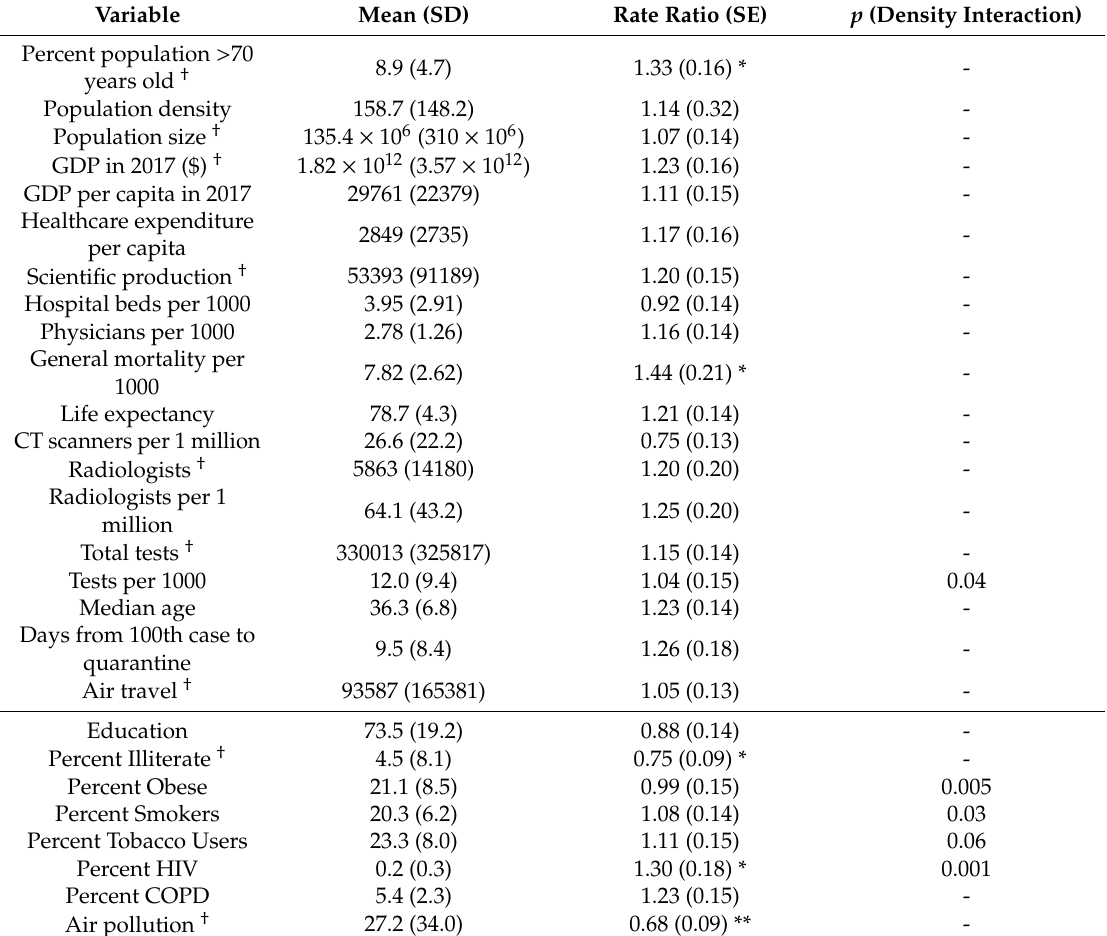
Table 1. Descriptive statistics (mean & SD) for candidate predictor variables, rate ratios (SE) for univariable relationships between predictors and case fatality rate, and p -value for the interaction of each predictor variable with population density (square root transformed). For comparability, all rate ratios reflect the e ff ect of the standardized predictor on case fatality